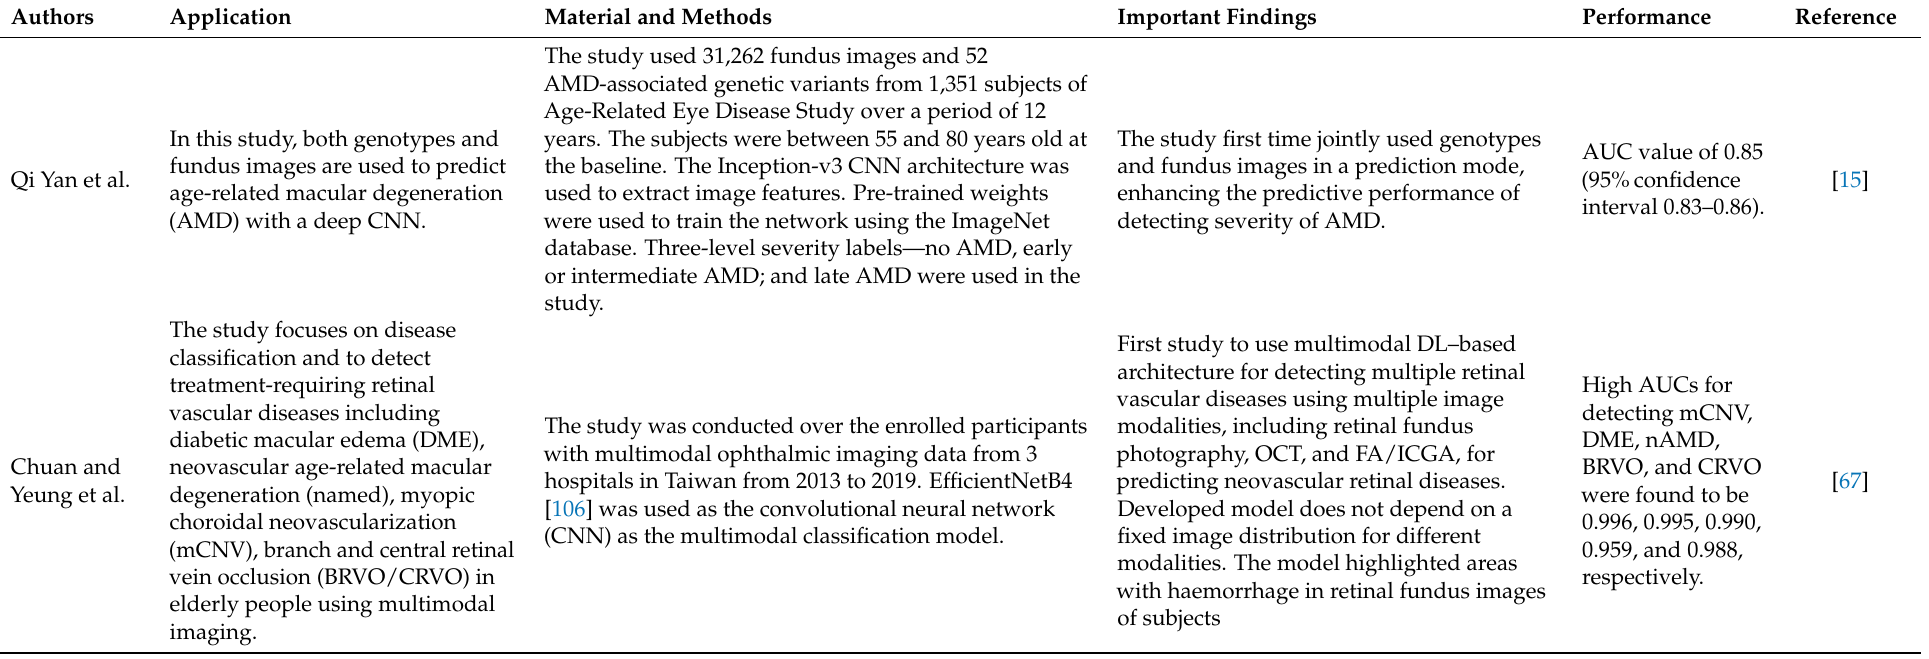
Table A1. Application of DL in